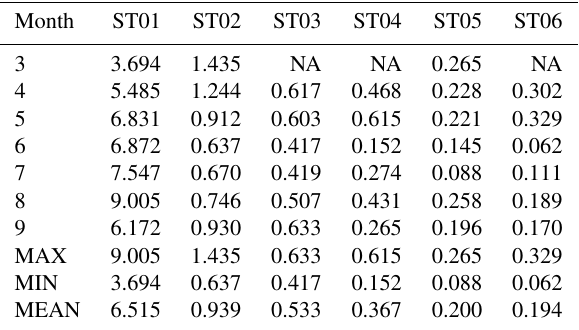
Table 1. Seasonal variability of a CDOM (440) for permanent sta-